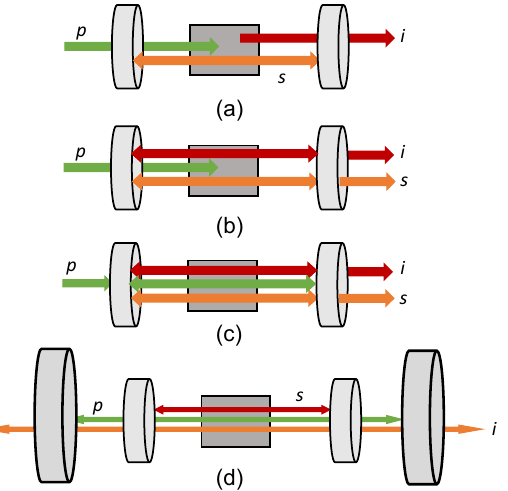
Figure 2. OPO laser ( a ) SRO, ( b ) DRO, ( c ) TRO, and ( d ) intracavity configurations; p, s, and i denotes pump, signal, and idler wavelengths respectively.